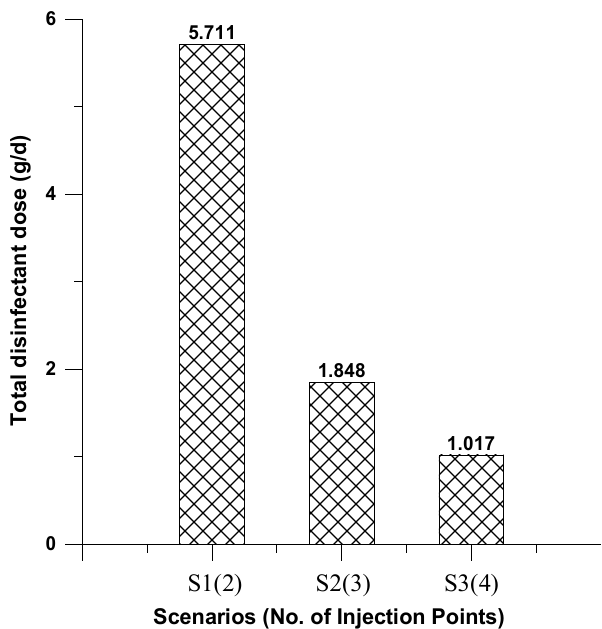
Figure 9. Total injection dose for each scenario (network 2).